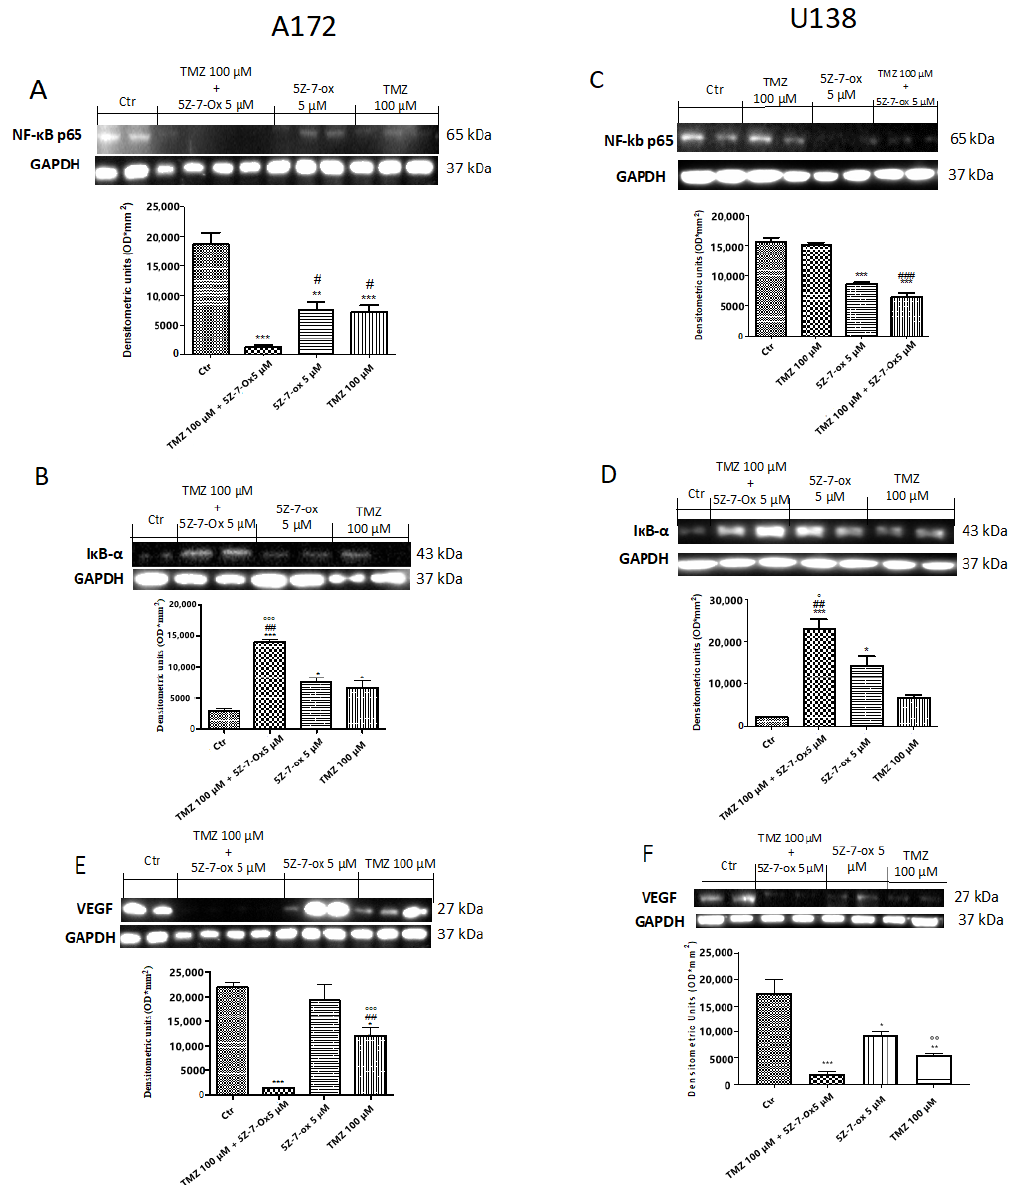
Figure 5. Effect of association (5Z-7-ox + TMZ) on Nf-kB pathway in glioblastoma cell lines. A low expression of I κ B α was detected in the CTR group, whereas stimulation with 5Z-7-Ox 5 µ M and TMZ 100 µ M for 24 h partially increased I κ B α levels ( B ) (A172) and ( D ) (U138). The association of TMZ with 5Z-7-ox considerably reduced IkB α degradation much more than single components (( B ) (A172) and ( D ) (U138)). Moreover, NF- κ B p65 expression was increased in the CTR group while the association significantly decreased its expression (( A ) (A172) and ( C ) (U138)) compared to TMZ alone. Data are representative of at least three independent experiments. ( A ) *** p < 0.001 vs. CTR, ** p < 0.01 vs. CTR, # p < 0.05 vs. TMZ; ( B ) *** p < 0.001 vs. CTR, * p < 0.05 vs. CTR, ## p < 0.01 vs. TMZ and ◦◦◦ p < 0.001 vs. 5Z-7-ox; ( C ) *** p < 0.001 vs. CTR and ### p < 0.001 vs. TMZ; ( D ) *** p < 0.001 vs. CTR, * p < 0.001 vs. CTR, ## p < 0.01 vs. TMZ and ◦ p < 0.05 vs. 5Z-7-ox. Western blot analysis showed a significant increase in VEGF expression in glioblastoma control cells (( E ) (A172) and ( F ) (U138), see densitometry analysis, respectively), while the association between 5Z-7-Ox and TMZ significantly down-regulated its expression (( E ) (A172) ( F ) (U138), see densitometry analysis, respectively) much more than single components (( E ) (A172) ( F ) (U138), see densitometry analysis, respectively). Data are representative of at least three independent experiments. ( E ) *** p < 0.001 vs. CTR, * p < 0.05 vs. CTR, ## p < 0.01 vs. TMZ, ◦◦◦ p < 0.001 vs. 5Z-7-ox; ( F ) *** p < 0.001 vs. CTR, ** p < 0.01 vs. CTR, * p < 0.05 vs. CTR, ◦◦ p < 0.01 vs. 5Z-7-ox. Original blots are shown inFigures S4 and